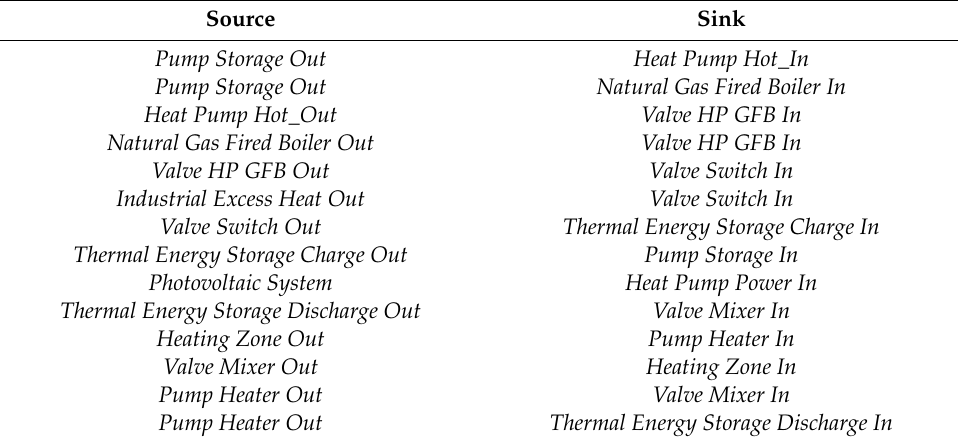
Table 2. Topology